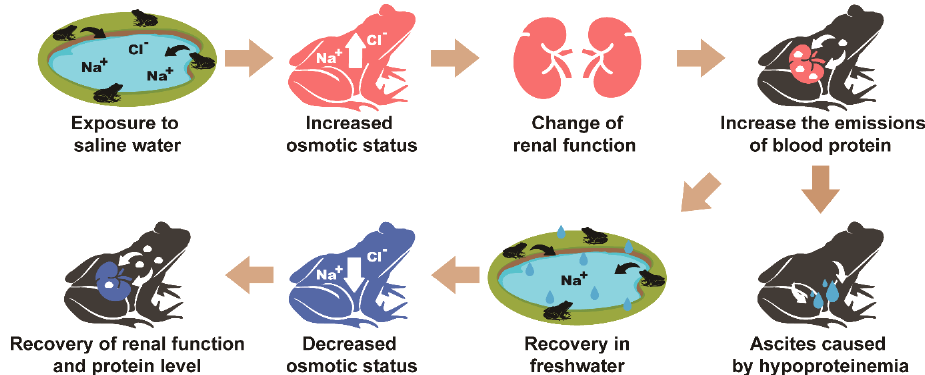
Figure 5. Ventral and femoral image of a frog in the severe condition: ( a ) ventral image of frog on 0 days (before salinity exposure), ( b ) femoral image of frog on 0 days (before salinity exposure), ( c ) ventral and femoral image of frog on 6 days (after salinity exposure). The individual in the image is the same frog, and after exposure to salinity, the skin in the ventral and femoral area is swollen and the ascites are full.